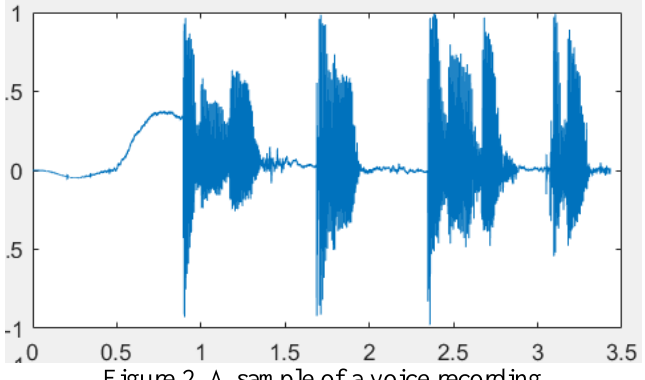
Figure 2. A sample of a voice recording